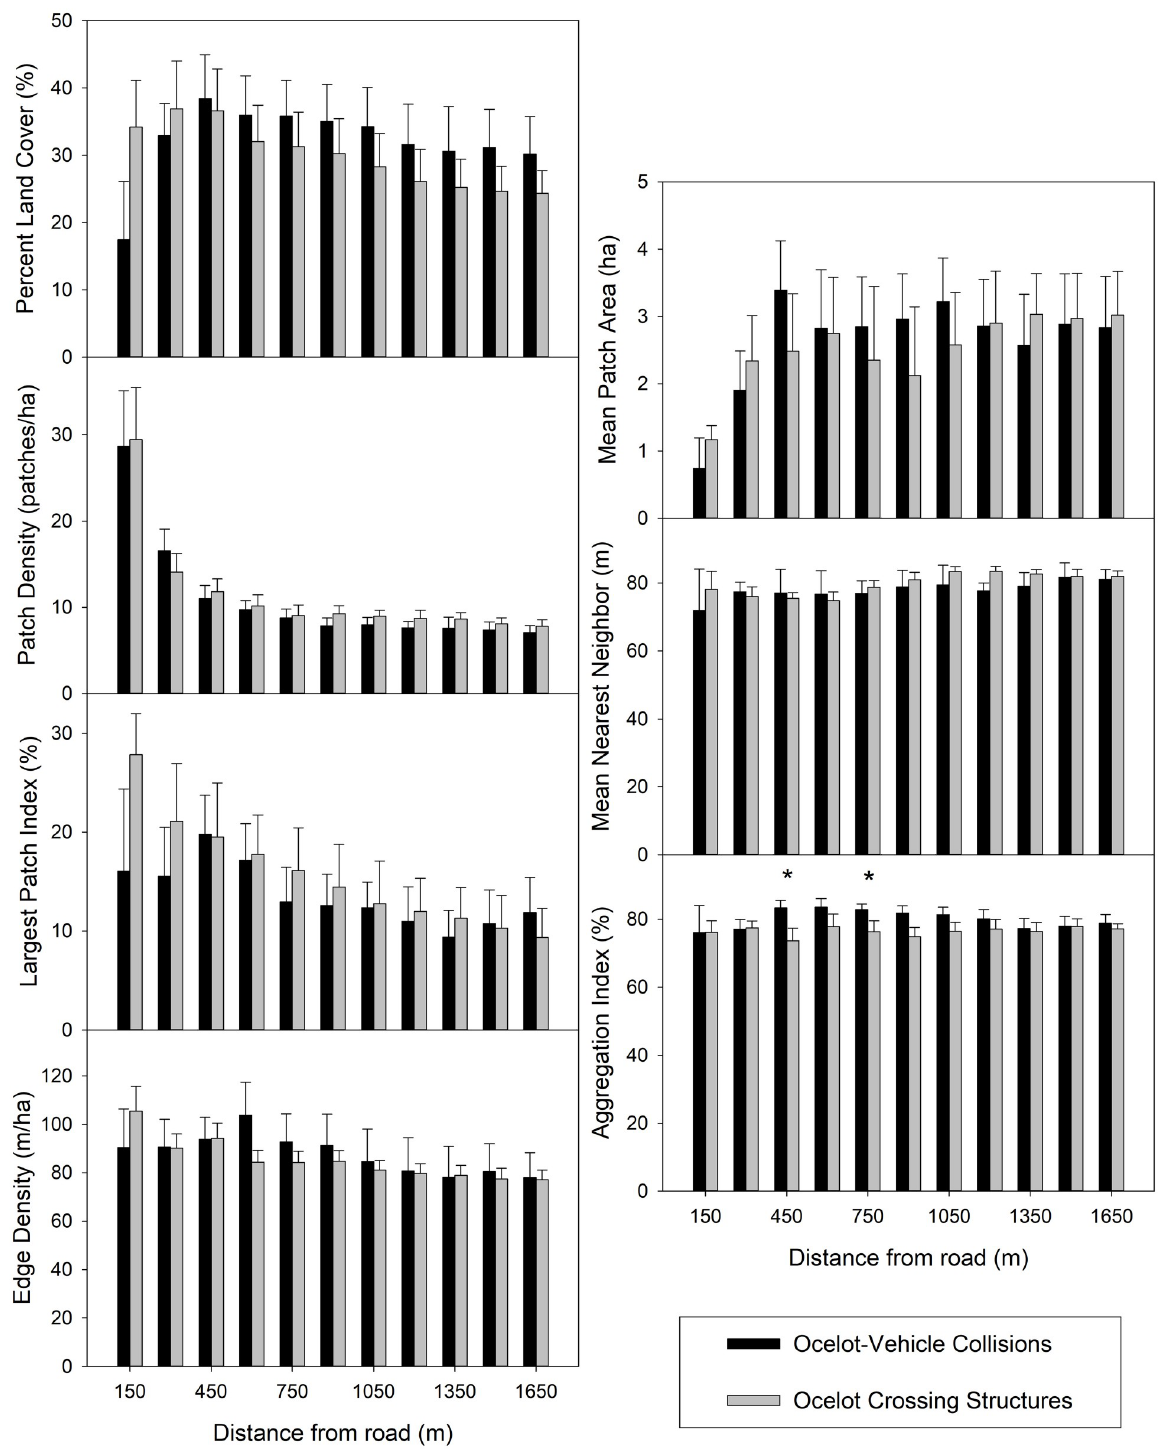
Fig 3. Median values of woody vegetation structure between 26 ocelot-vehicle collision sites and 56 ocelot crossing structures. Asterisks on top of bars indicate significant differences based on Kolmogorov-Smirnov tests.